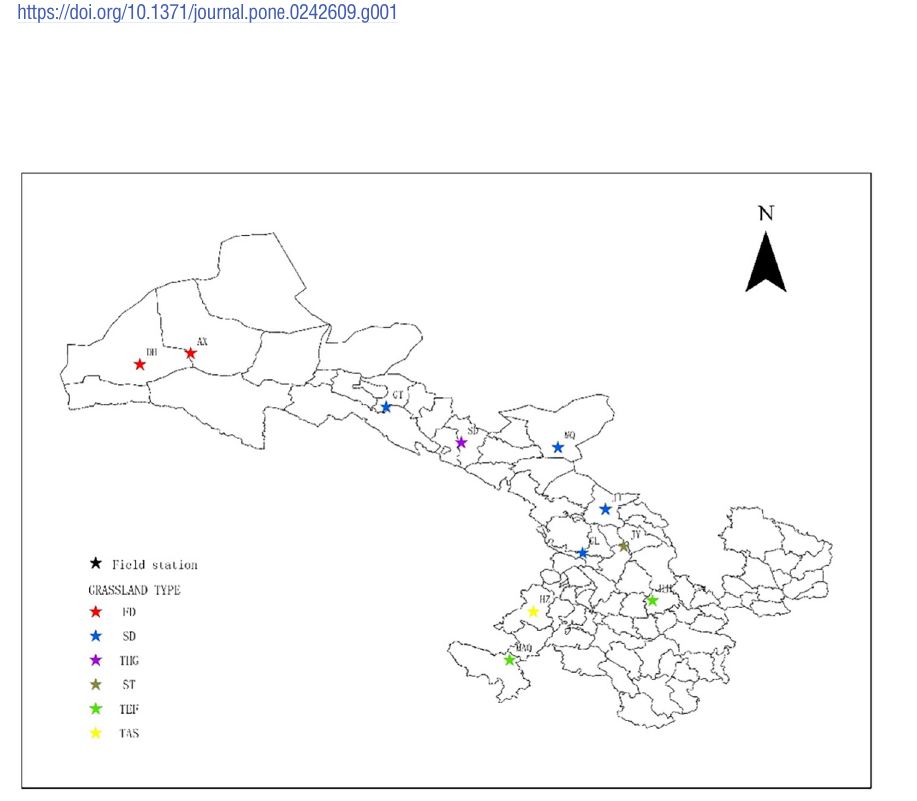
Fig 2. Spatial distribution of field observation station in Gansu, China. (See Table 1 for site abbreviations).